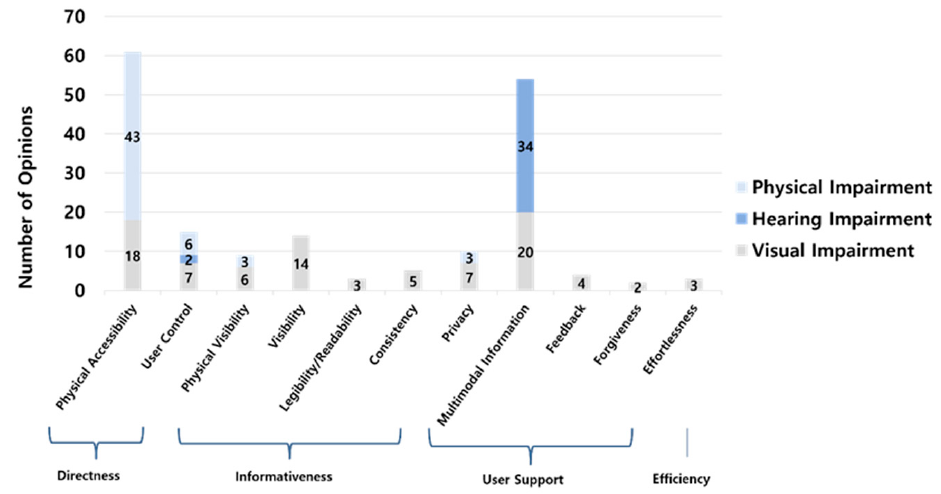
Figure 3. Number of opinions according to subcategories of accessibility.